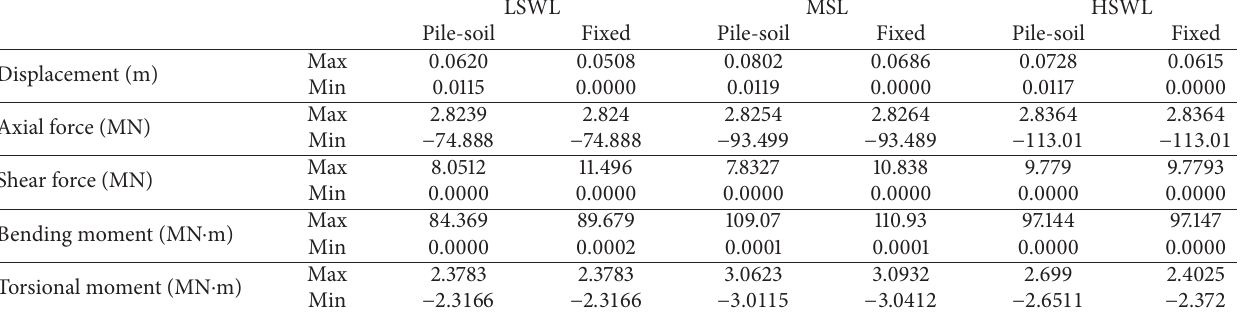
Table 13: Structural results under regular wave condition.